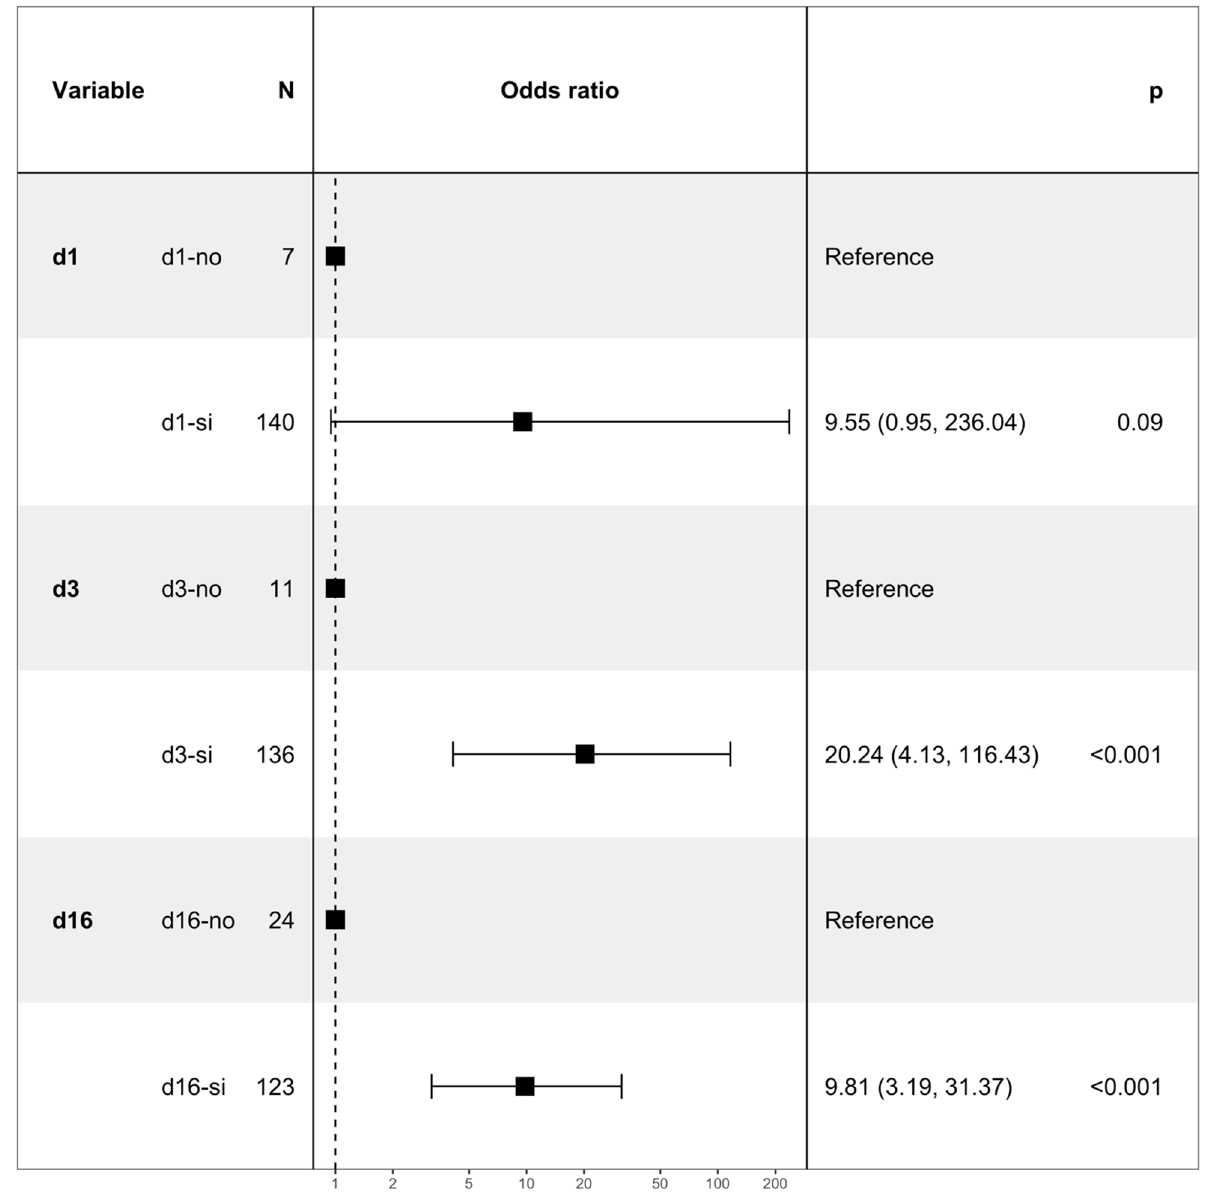
Figure 2. Forest plot related to multivariate logistic regression .